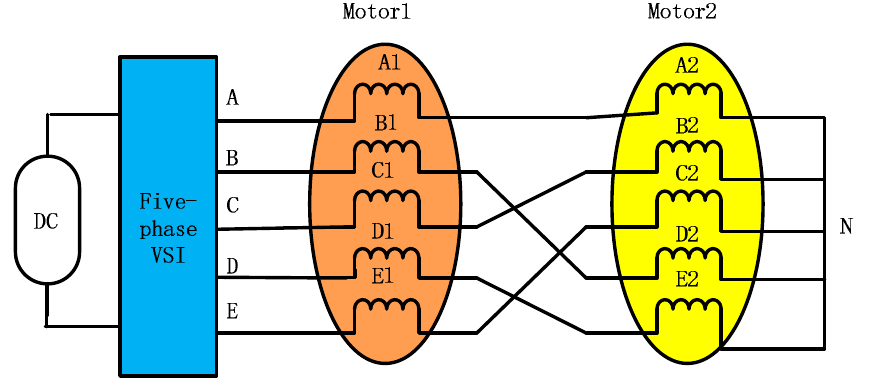
Figure 2. This connection in Figure 2 is based on the space voltage vector distribution in double subspaces of five − phase VSI. Although it is consistent with the basic principle of traditional connection, it is slightly different from the connection method of dual motors in series [23].